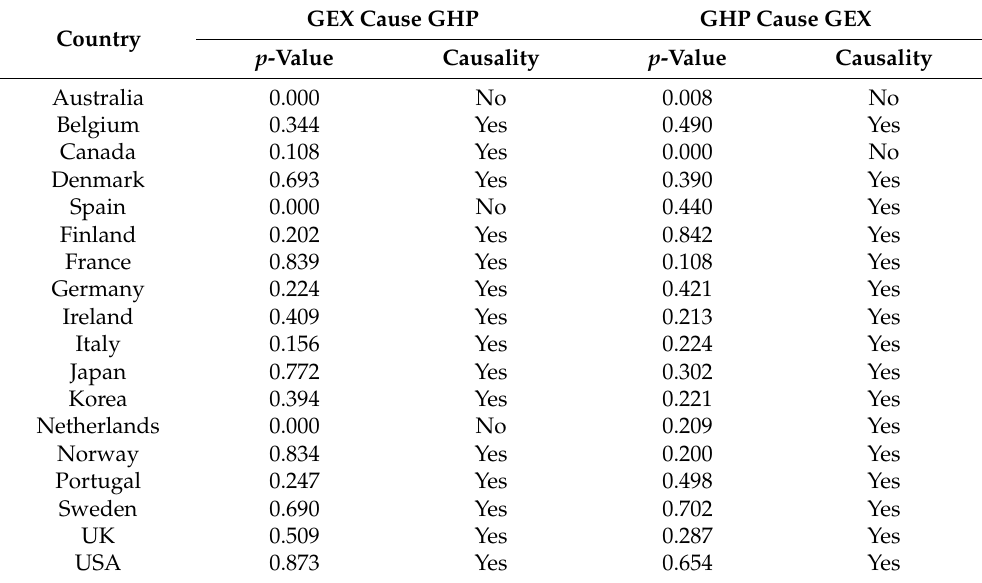
Table 5. The results of quantile Granger causality between housing prices and exchange rates in the bust market in OECD countries (quantile = 0.1). GEX Cause GHP GHP Cause GEX Country p -Value Causality p